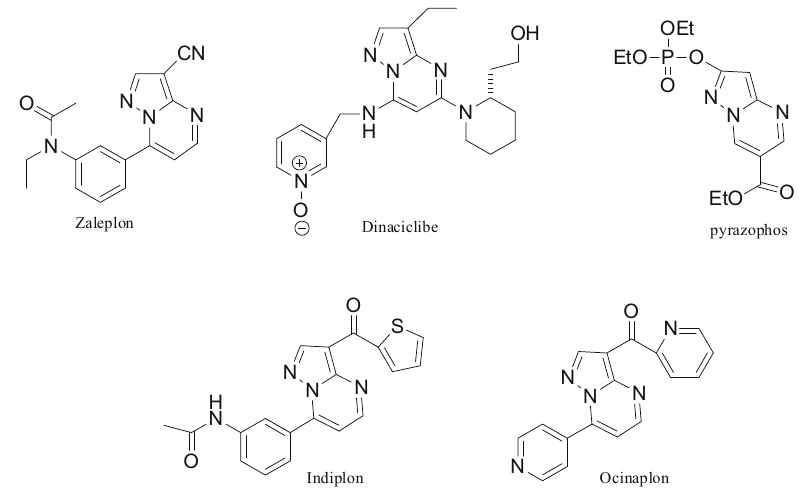
Figure 1: Pyrazolo [ 1,5 - a ] pyrimidines marketed